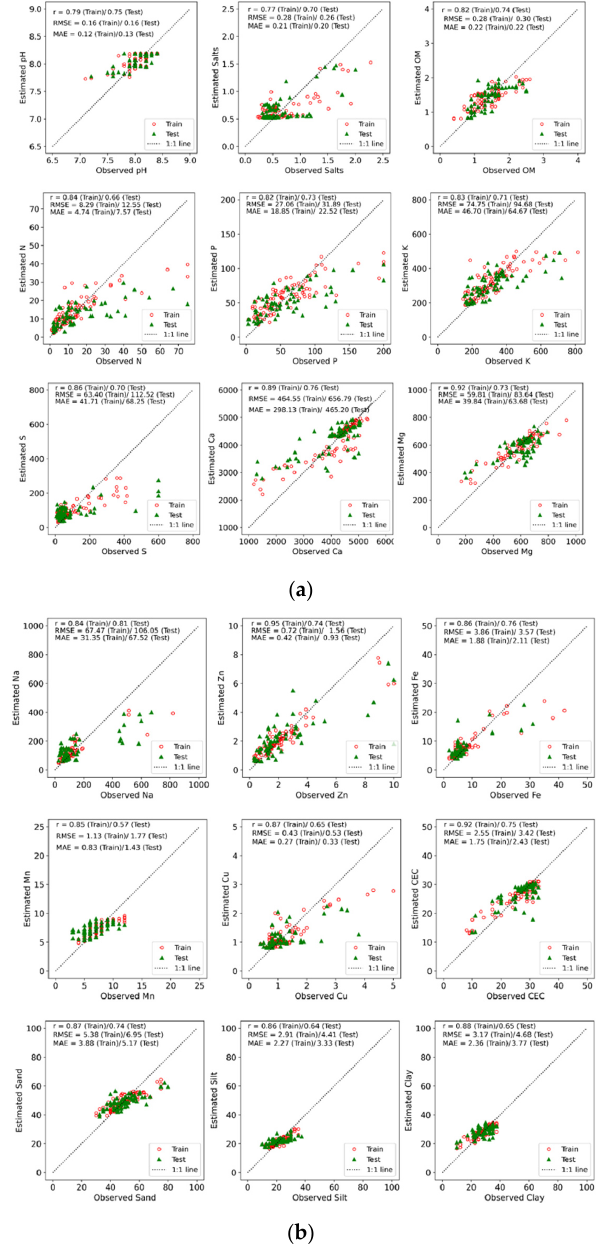
Figure 2. ( a ) Scatter plot of the estimated to observed values of each soil property as per